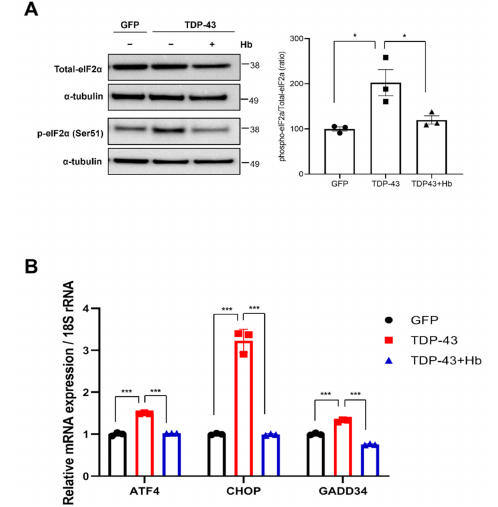
Figure 4. Hydroxocobalamin mitigates the TDP-43-induced unfolded protein response in neuronal cells. SH-SY5Y cells were infected with GFP or GFP-tagged human WT TDP-43 lentiviruses and treated with Hb (10 µ M) simultaneously for 1 day. ( A ) Immunoblot analysis of eIF2 α phosphorylation in TDP-43-expressing cells. Hb treatment significantly reduced the increase in eIF2 α phosphorylation induced by TDP-43. Quantification was performed in three independent experiments and normalized to α -tubulin. Means ± SD. * p < 0.05 (one-way ANOVA with Tukey’s multiple comparison test). ( B ) Transcript levels of ER stress-related genes, including ATF4 , CHOP , and GADD34 , were detected using real-time PCR. 18S rRNA was used as an internal control. Error bars represent the mean values ± SD of three independent experiments. The significance of differences was determined using one-way ANOVA with Tukey’s multiple comparison test (*** p < 0.001). Taken together, these data indicate that Hb modulates ER stress induced by TDP-43, thereby mitigating